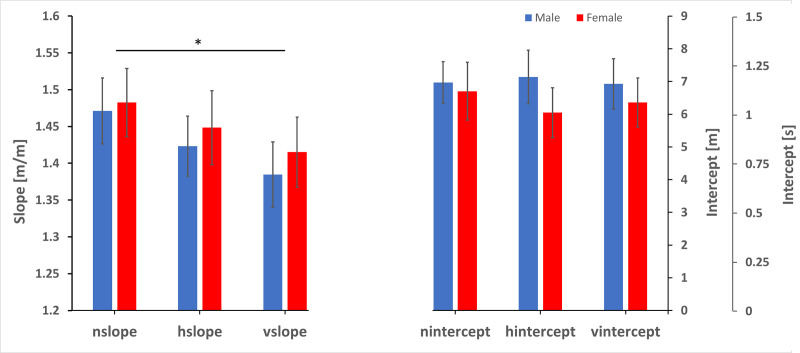
Slopes and intercepts.Slopes and intercepts for linear fits to the three vection conditions broken down by sex. (Blue males, red females). For the slope there is a significant difference between no jitter and vertical jitter conditions. For the intercept there was no significant difference between the conditions. nslope and nintercept refer to the no jitter condition, hslope and hintercept refer to the horizontal jitter condition while vslope and vintercept refer to the vertical jitter condition. The vertical axis for slopes is on the left while the one for intercepts is on the right. The intercept axis is given in m and the corresponding time in seconds.